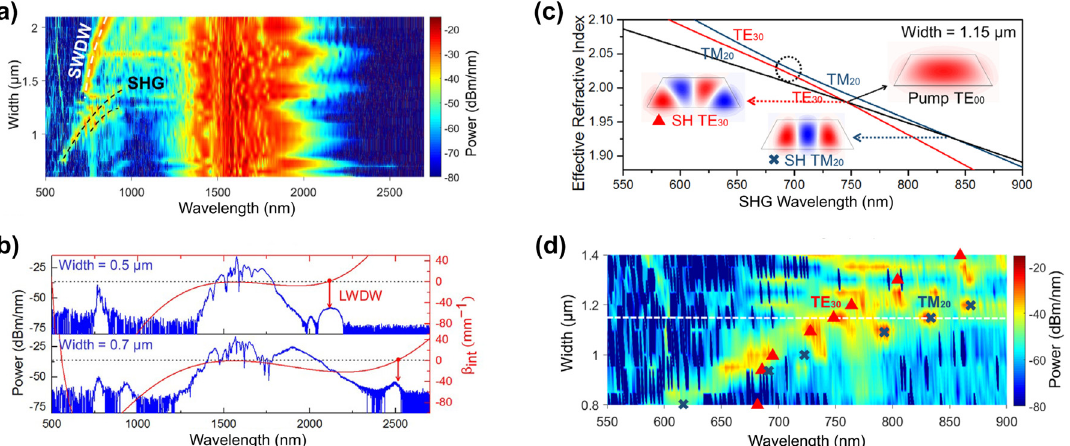
Figure 15: SCG in LNOI waveguides. (a) Experimental spectra compiled for many different waveguide widths. (b) Experimental spectra (blue) including simulated integrated dispersion (red) for two waveguide widths. (c) Effective refractive index for several modes for a waveguide width of 1.15 um. (c) Simulated phase-matching wavelengths for higher order modes (TE30 as red triangles and TM20 as blue crosses) mapped onto experimental data for different waveguide widths. Adapted from